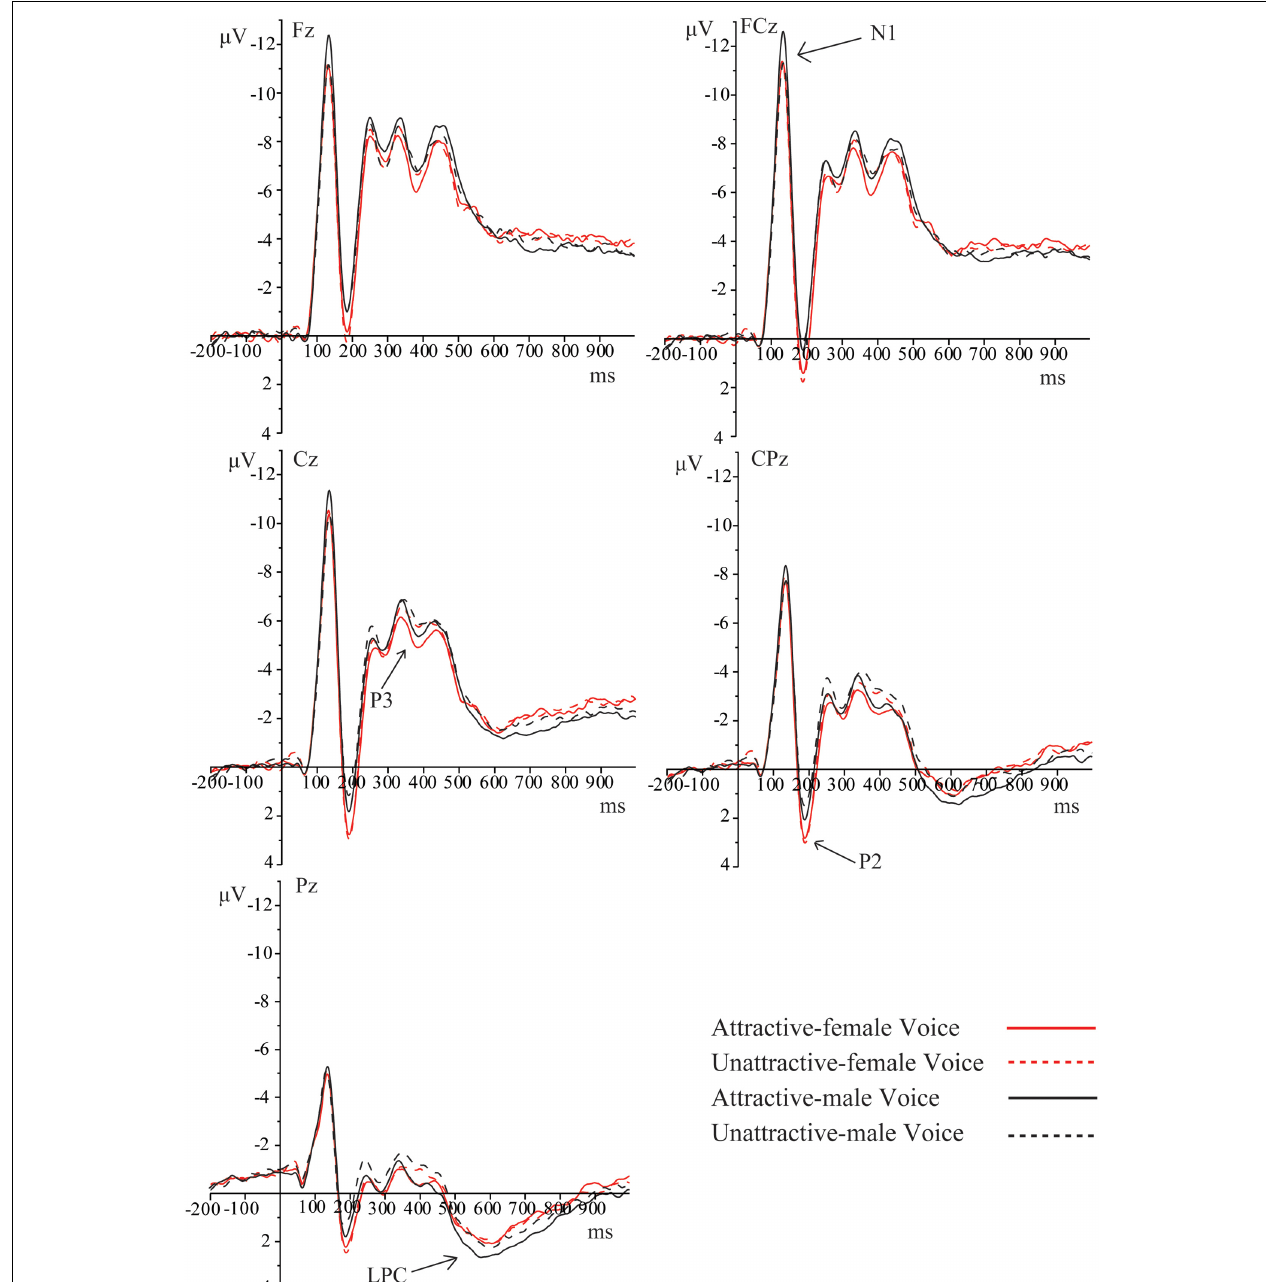
FIGURE 3 | Grand-average ERPs at Fz, FCz, Cz, CPz, and Pz for the four conditions. The time window for N1 was 120–170 ms. The time window for P2 was 170–230 ms. The time window for P3 was 350–440 ms. The time window for LPC was 470–700 ms. ERPs were time-locked to the onset of each voice.